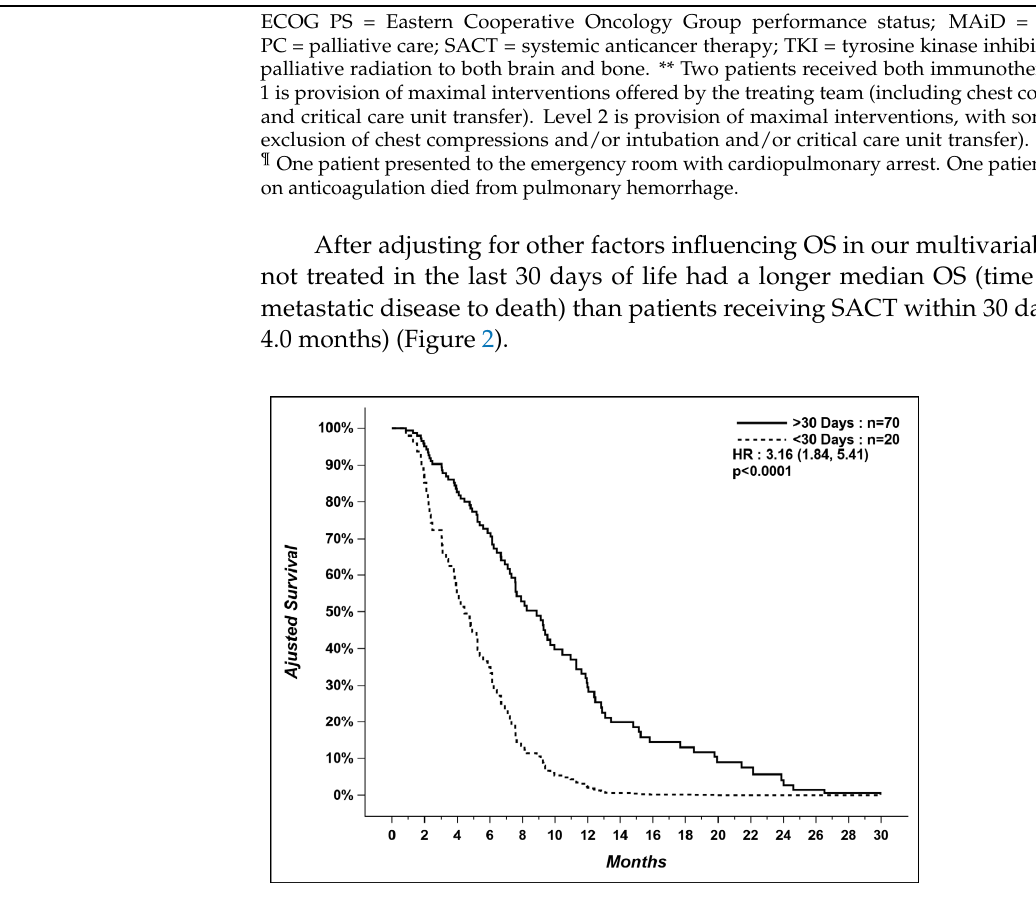
Figure 2. Overall survival of patients who received systemic therapy within last 30 days versus patients who did not.